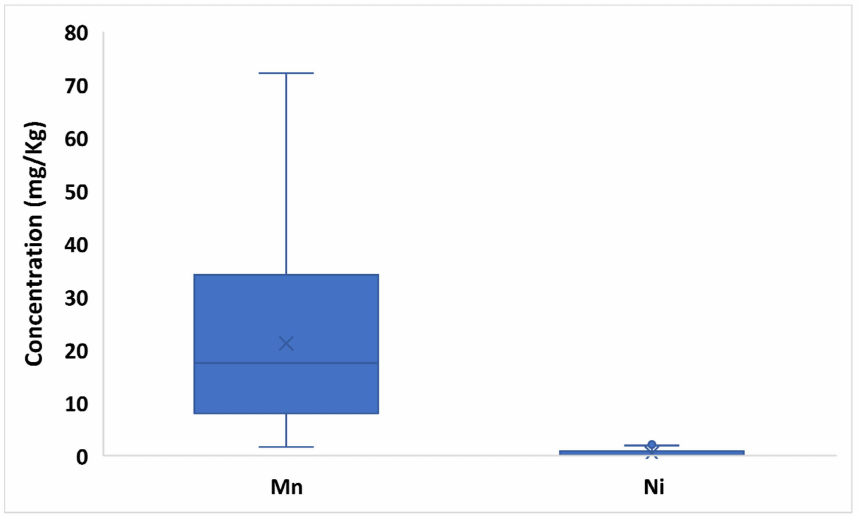
Figure 3. Box plot of probably essential trace elements (Mn, Ni) concentration in hemps. The “ × ” indicates the average value of each element, whereas the outlier points display the outlier data lying either below the lower whisker line or above the upper whisker